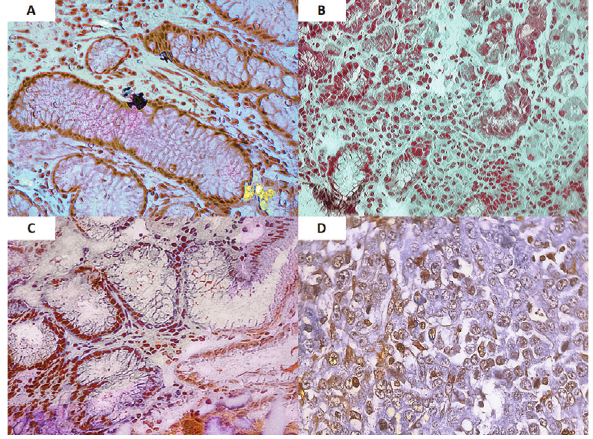
Figure 4 - Pre-neoplastic and neoplastic lesions positive for COX-2 immunoreactivity. (A) Chronic gastritis with plasmocytes; (B) Atrophic gastritis (atrophy); (C) Intestinal metaplasia; (D)